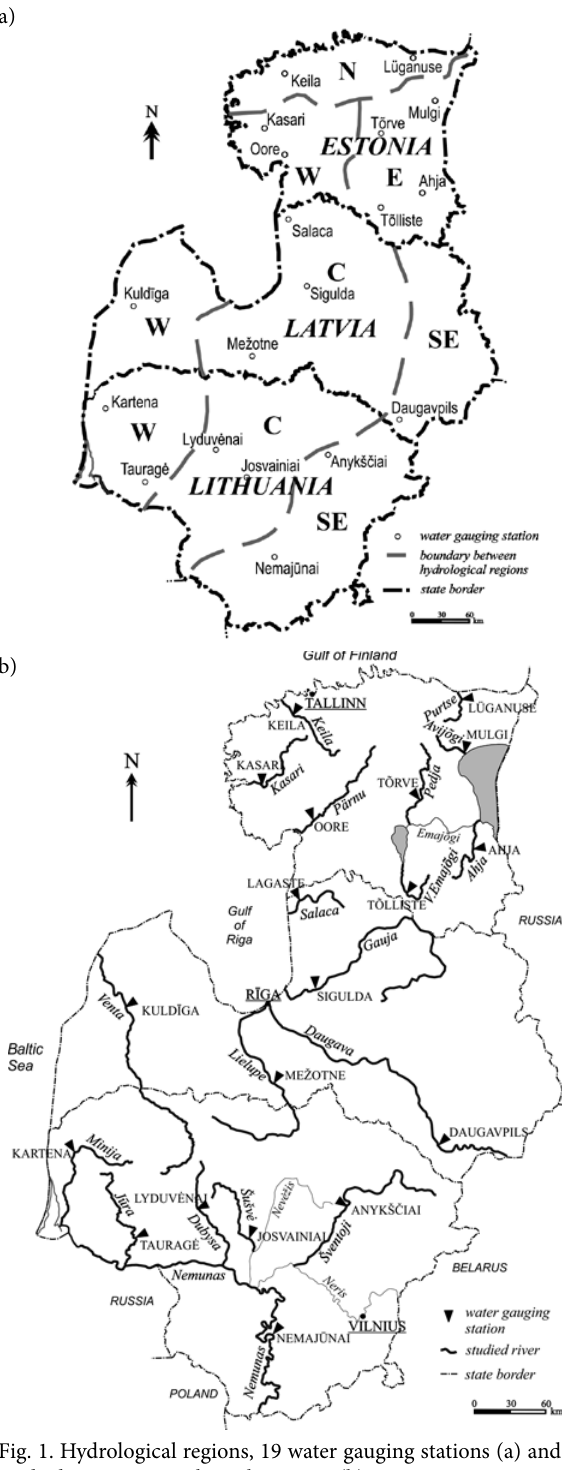
Fig. 1. Hydrological regions, 19 water gauging stations (a) and studied rivers across the Baltic States